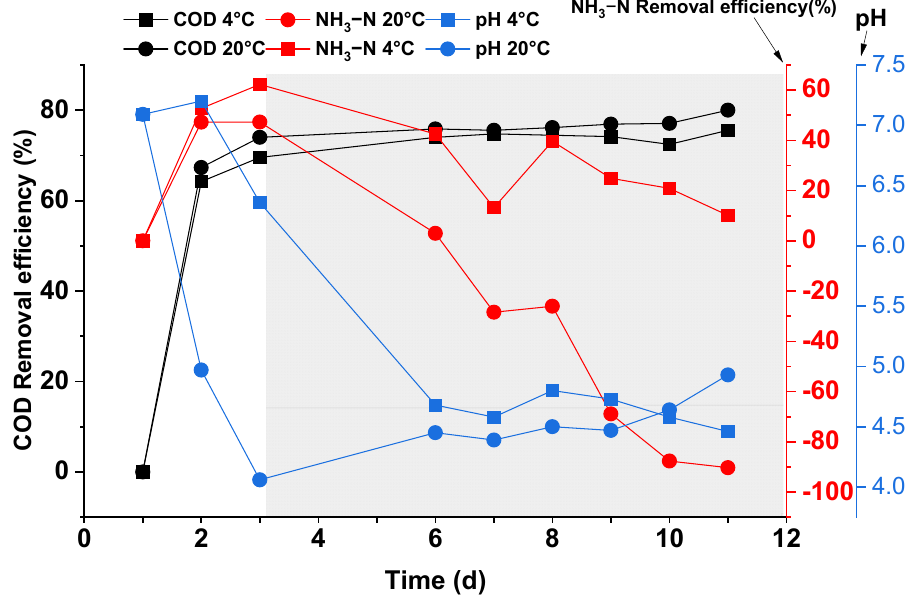
Figure 6. Variation of supernatant in terms of COD, NH 3 ‐ N removal efficiency, and pH during the experiment. the